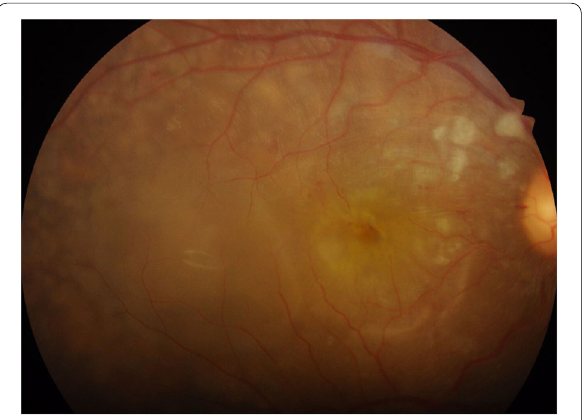
Fig. 1 Fundus photograph of the right eye of a patient with hypertensive retinopathy showing cotton wool spots, serous detachment of the macula, and numerous deep pale yellow Elschnig spots surrounding the posterior